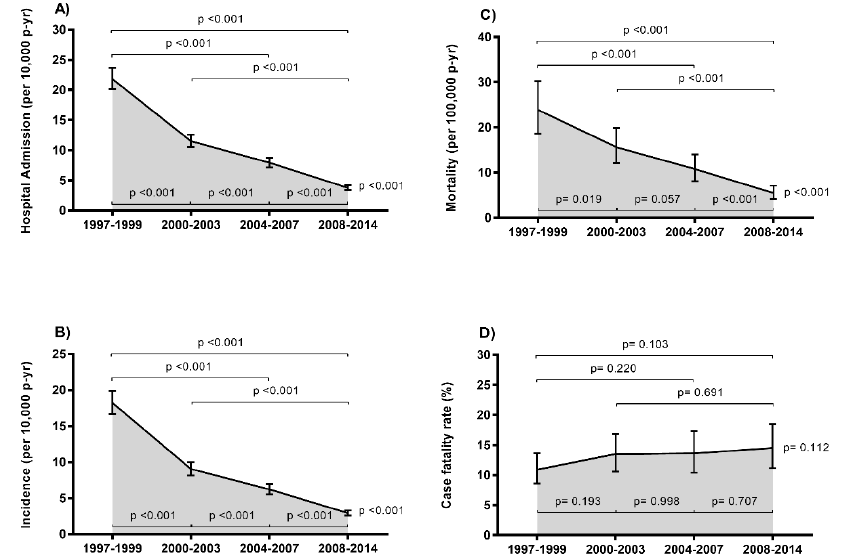
Figure 2. Epidemiological trends of infective endocarditis in HIV-infected patients in Spain (1997 to